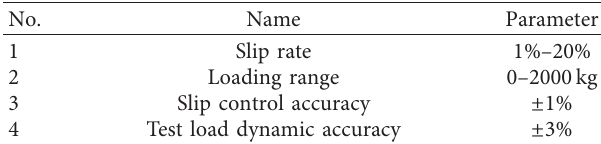
Figure 2: Structure composition of testing machine: (a) main view; (b) top view. 1, accompany module drive motor; 2, accompany module headstock; 3, test module headstock; 4, test module drive motor; 5, test module; 6, accompany module; 7, loading module; 8, load sensor; 9, mating roller; 10, test roller. Table 1: Main control index and precision requirement.